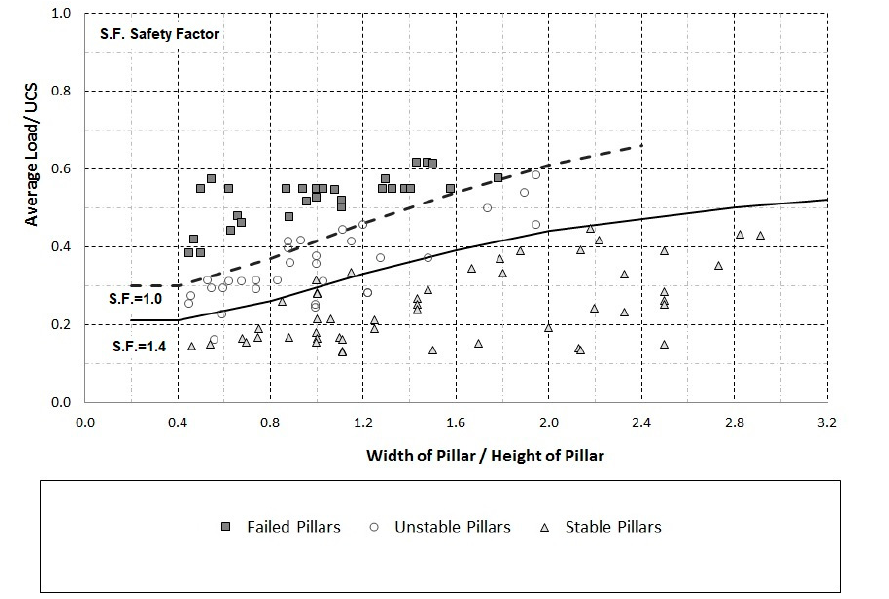
Figure 6. Empirically developed Pillar Stability Graph [12].